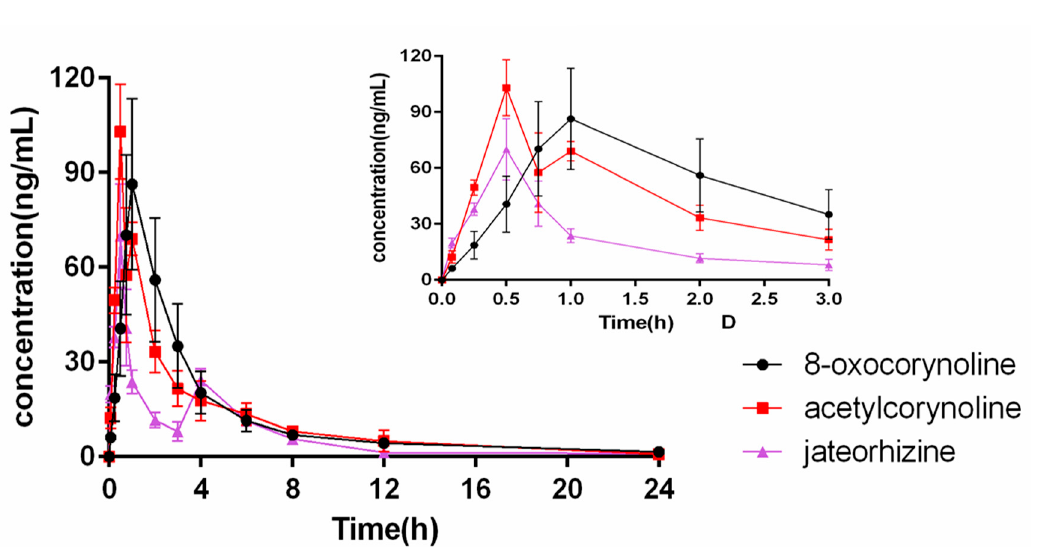
Figure 2. The concentration of fourteen alkaloids in plasma-time profiles of Z23, coptisine, berberrubine, Sanguinarine, worenine, berberine, jateorhizine, columbamine, Palmatine, protopine, tetrahydropalmatine, corynoline, 8-oxocorynoline, acetylcorynoline in beagle plasma after oral administration of C. bungeana extract. Values are expressed as mean ± SD ( n = 6). The mean ± SD plasma concentration-time profiles of the fourteen alkaloids in the beagle dog plasma after oral administration of C. bungeana extract ( A – D ) from 0 to 3 h, respectively. ( n = 6).